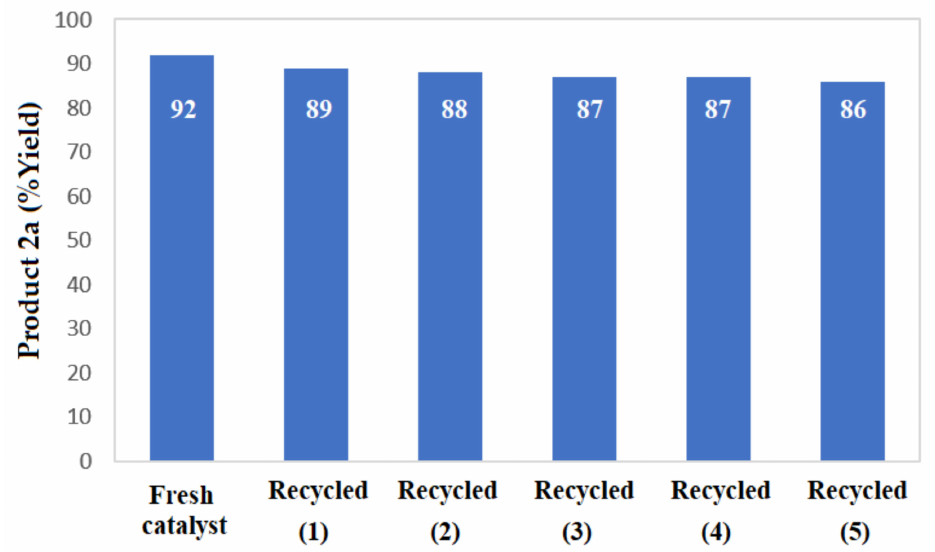
Figure 6. Recyclability of the nanocomposite as basic